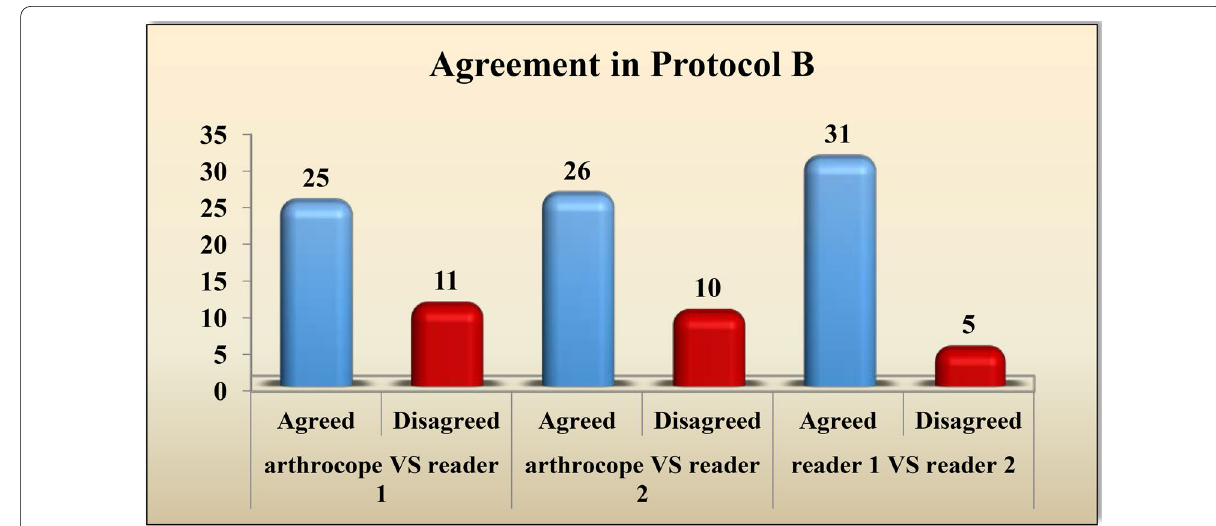
Fig. 10 The agreement between each reader and the arthroscopy, in addition to the interobserver agreement for protocol B